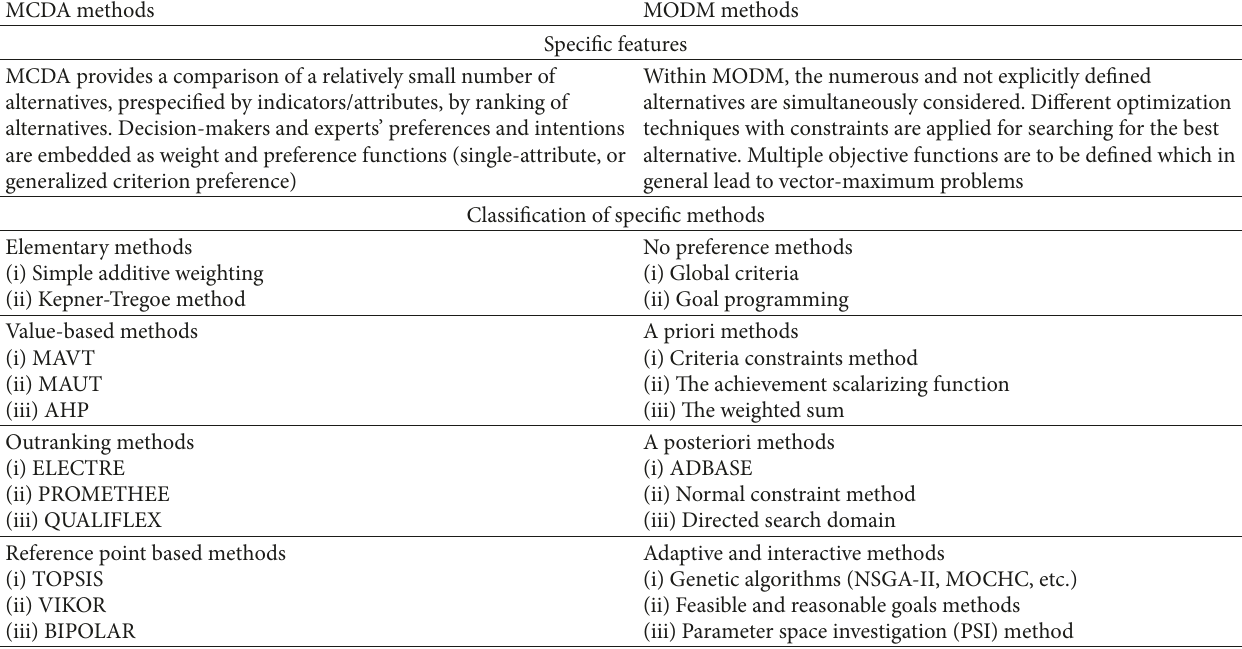
Table 5: The most commonly used MCDM